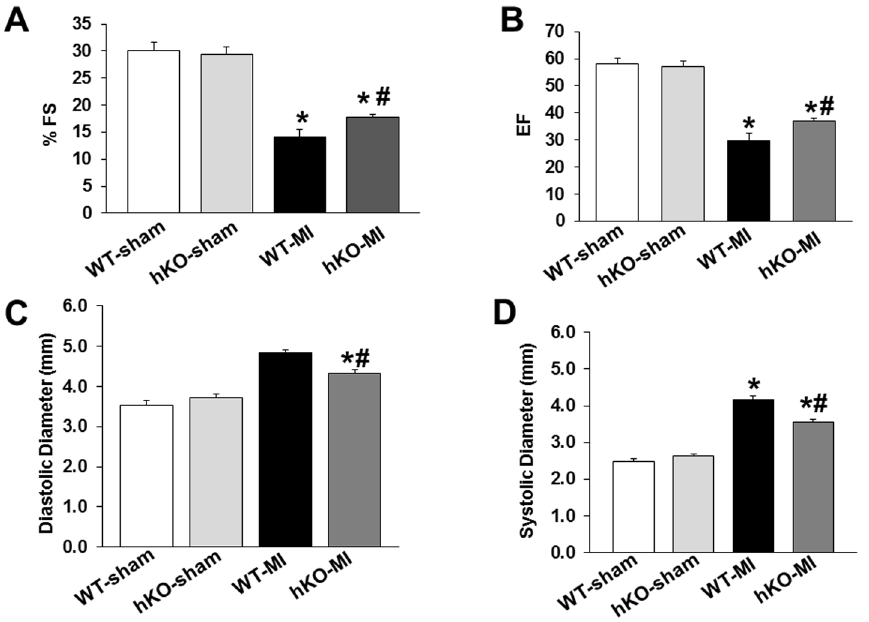
Figure 2. ATM deficiency improves LV function 7 days post-MI. MI was performed in WT (n=10) and ATM hKO (n=12) mice. Indices of cardiac function (percent fractional shortening, %FS; ejection fraction, EF) and structure (LV end diastolic diameter, LVEDD; LV end systolic diameter, LVESD) were measured using echocardiography 7 days after MI. A. %FS; B. EF; C, LVEDD; D. LVESD; *p<0.05 vs sham; # p<0.05 vs WT-MI; n=10-12. doi: